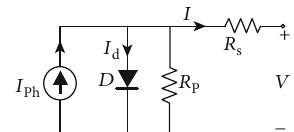
Figure 3: Simpli fi ed equivalent circuit of a PV cell